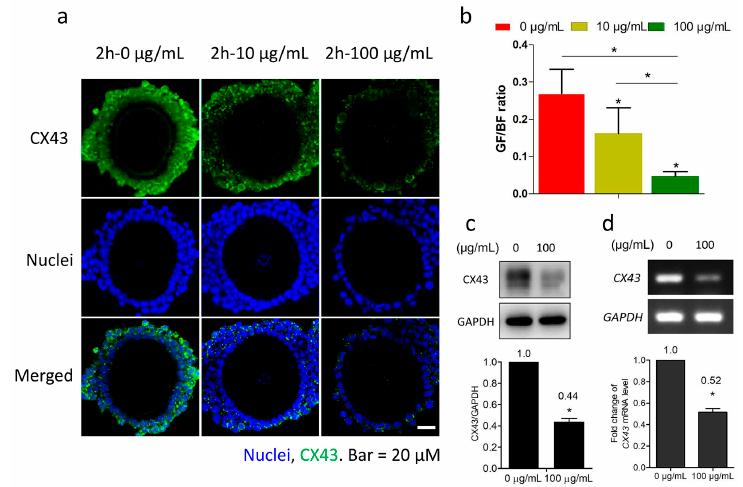
green fluorescence intensity (CX43). BF, blue fluorescence intensity (nuclei). Each experiment was